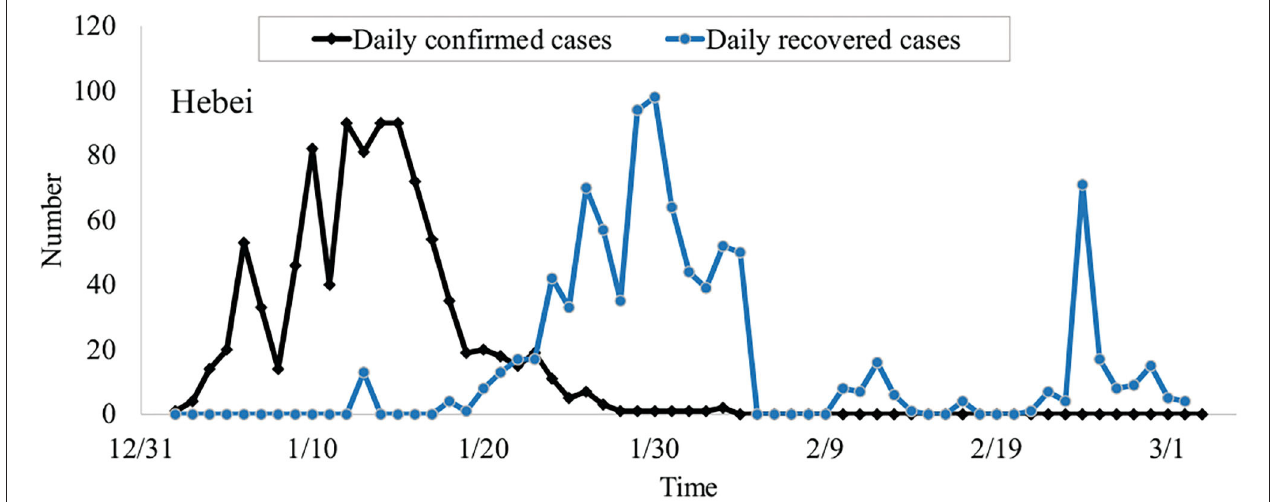
FIGURE 1 | The daily confirmed cases and recovered cases of COVID-19 in Hebei province on January